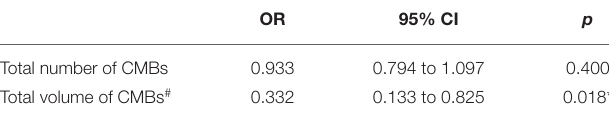
OR, odd ratio; CI, confidence interval; CMBs, cerebral microbleeds. # indicates log 10 - transformation, * indicates p < 0.05. Values are adjusted for age, education, BMI, HbA1c, TC, HDL, LDL, and volume of